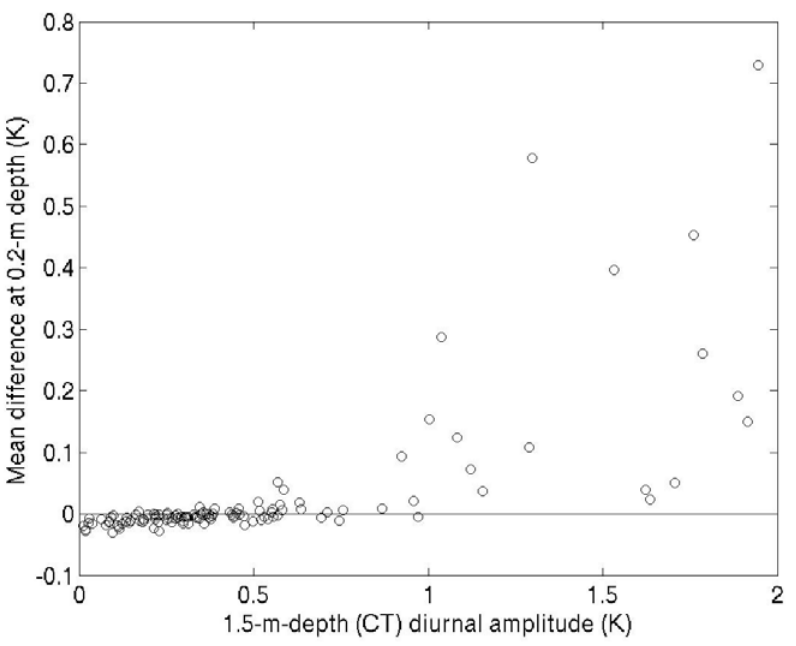
Figure 6. Temperature differences between the mark side and the opposite side at 0.2 m depth as a function of the diurnal amplitude of the CT temperature at 1.5 m from 3 February 2005 to 31 May 2006. The temperature differences were averaged between 1100 and 1500